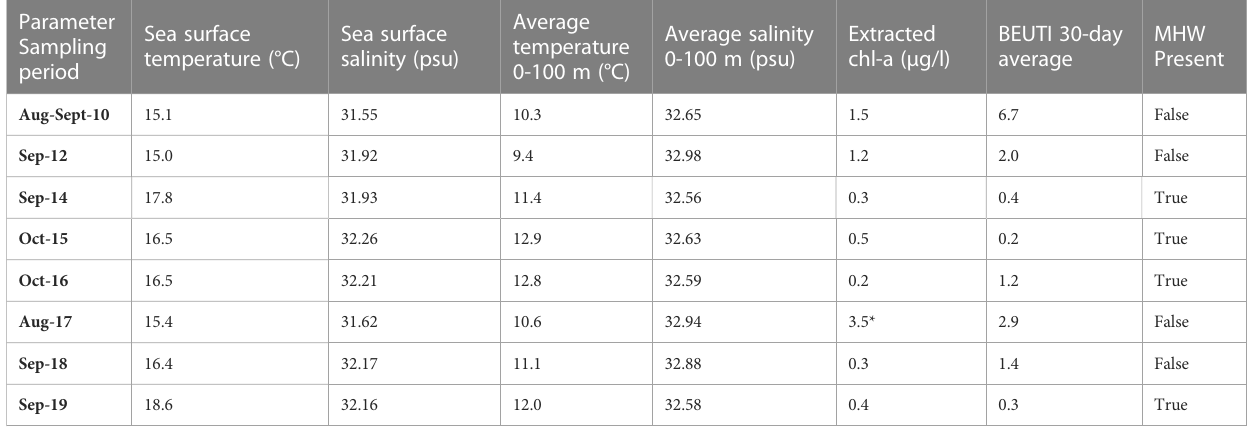
TABLE 2 Average annual environmental